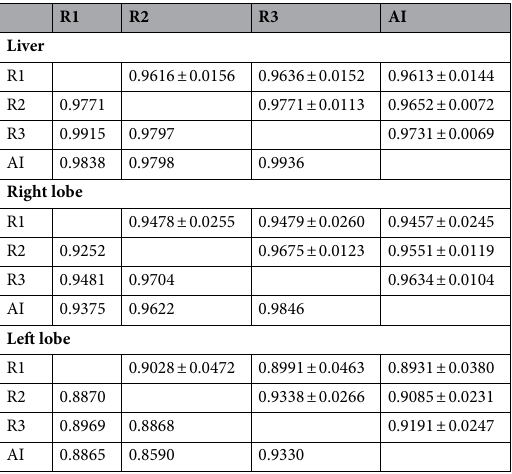
Table 1. Evaluation between the three readers (R1-R3) and the proposed tool (AI). The upper triangular matrix states Sørensen-Dice coefficients. The lower triangular matrix states R2 coefficients of the respective